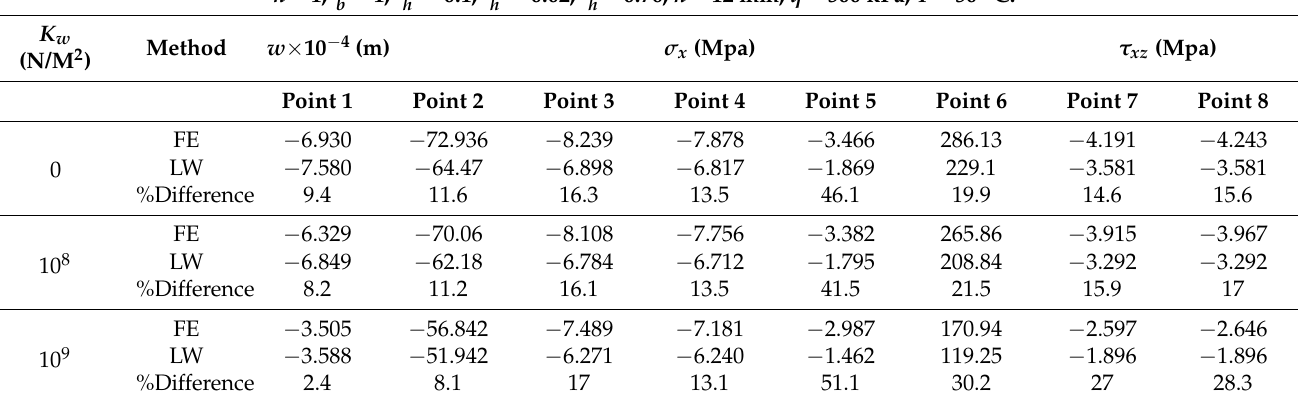
Table 7. Comparison of the results based on LT and those of FE findings.